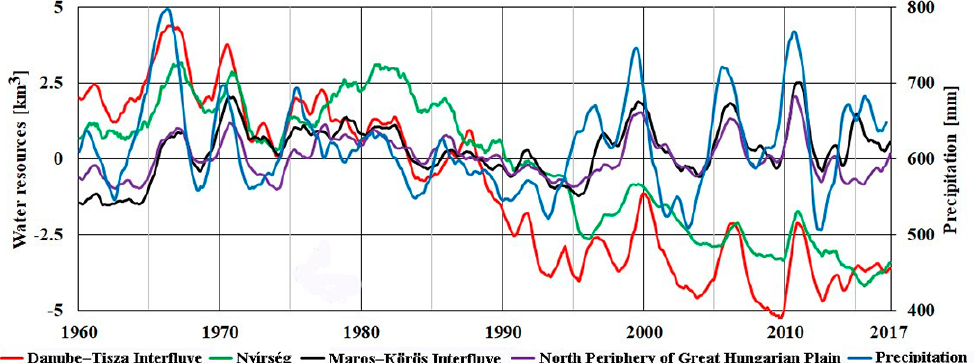
Figure 4. Precipitation and groundwater resources in four regions of the Great Plain 1960-2017* * The volume of precipitation was displayed as the 24 months moving average of the annual precipitation. The reference „0” value of the shallow groundwater resources was determined as the mean of the estimated values for the period of 1950-2010